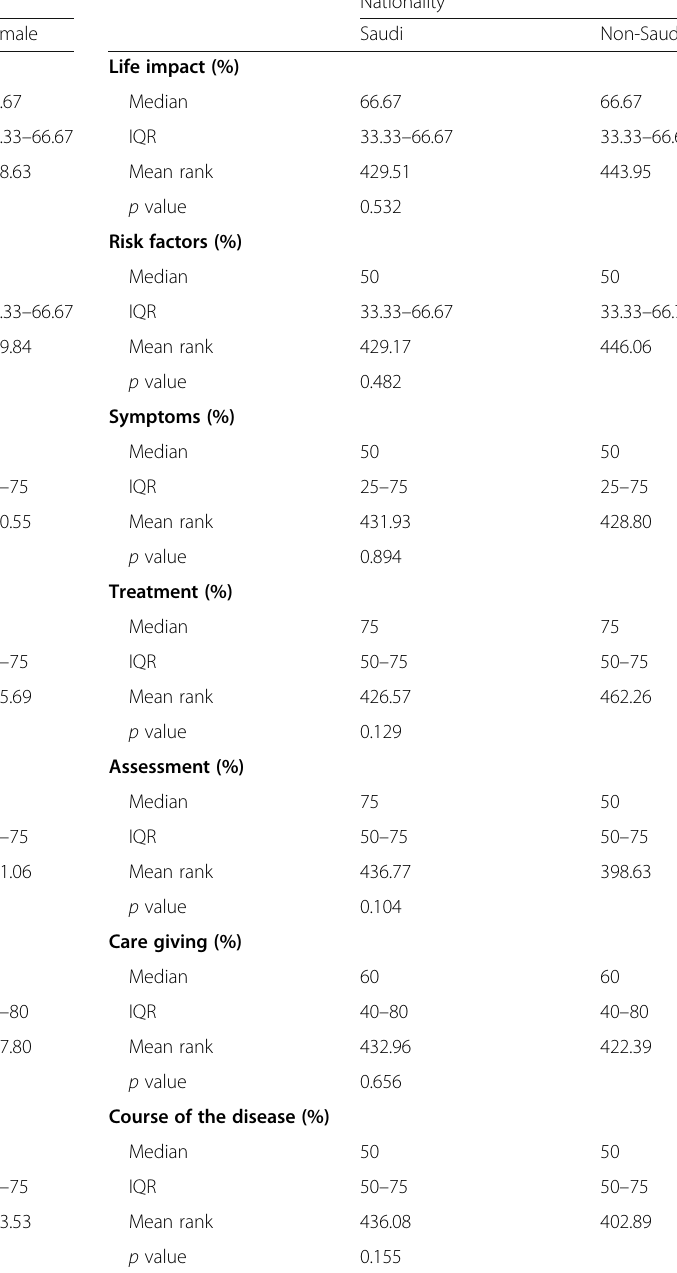
Table 4 Knowledge of different aspects of Alzheimer ’ s disease according to participant ’ s gender